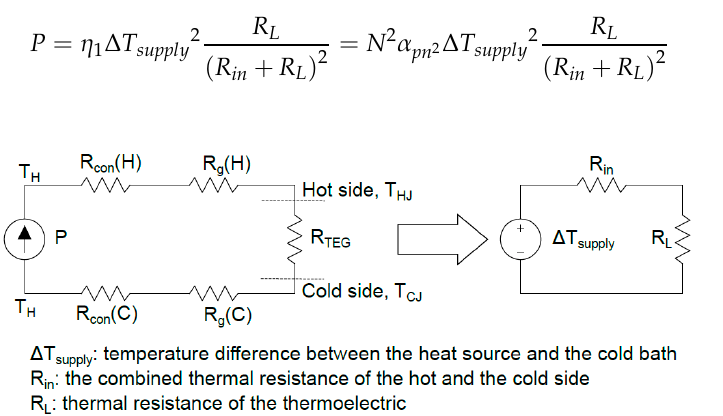
Figure 16. Equivalent electro-thermal circuit of a thermoelectric energy harvesting device.